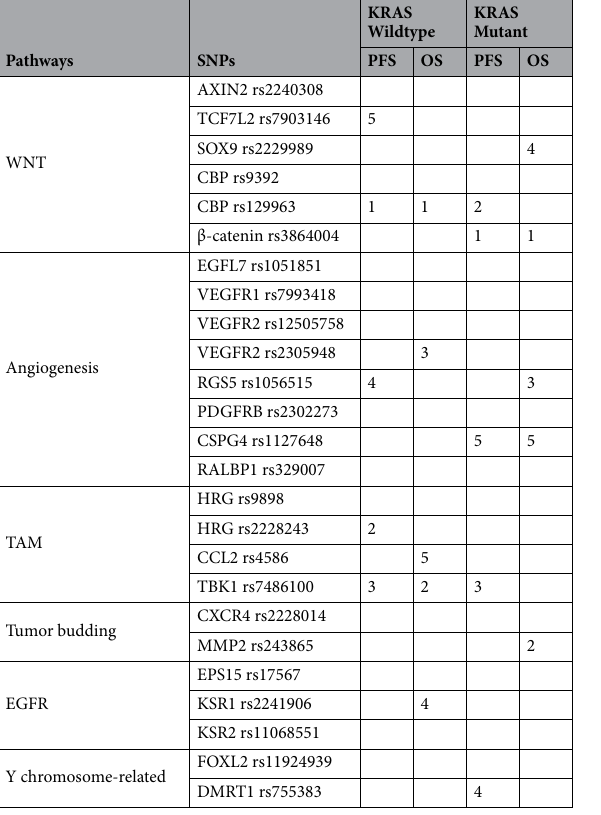
Table 2. Summary for RSF results by KRAS